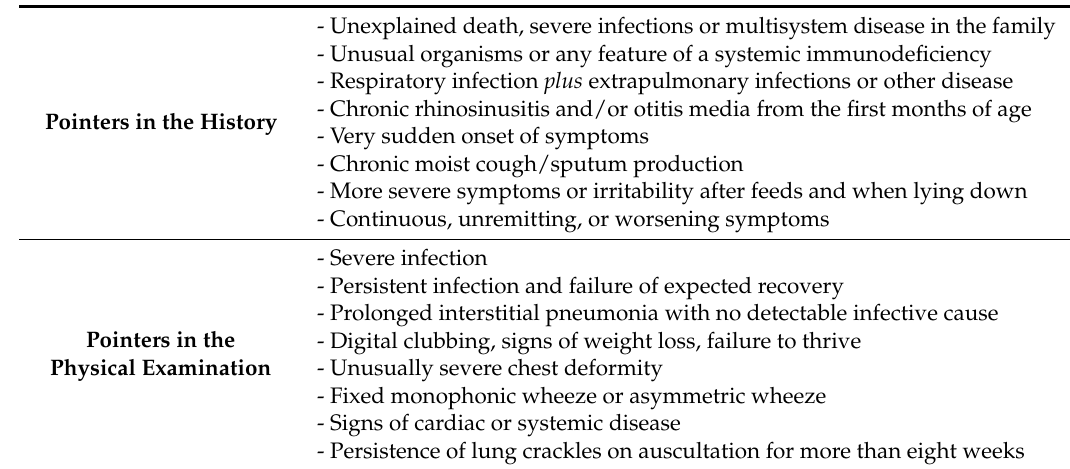
Table 2. Pointers that should lead to further investigation in a child with recurrent pneumonia.